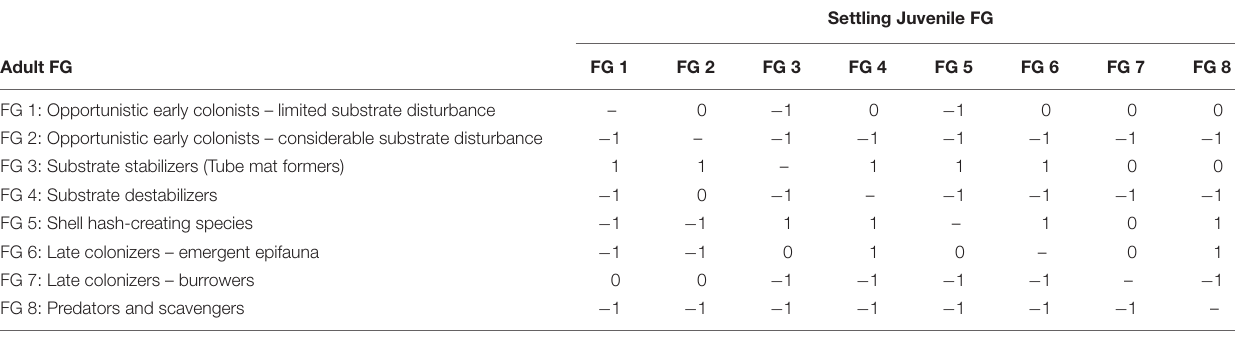
TABLE 3 | Adult-Juvenile interaction matrix used to score functional group interaction in cells of the landscape.